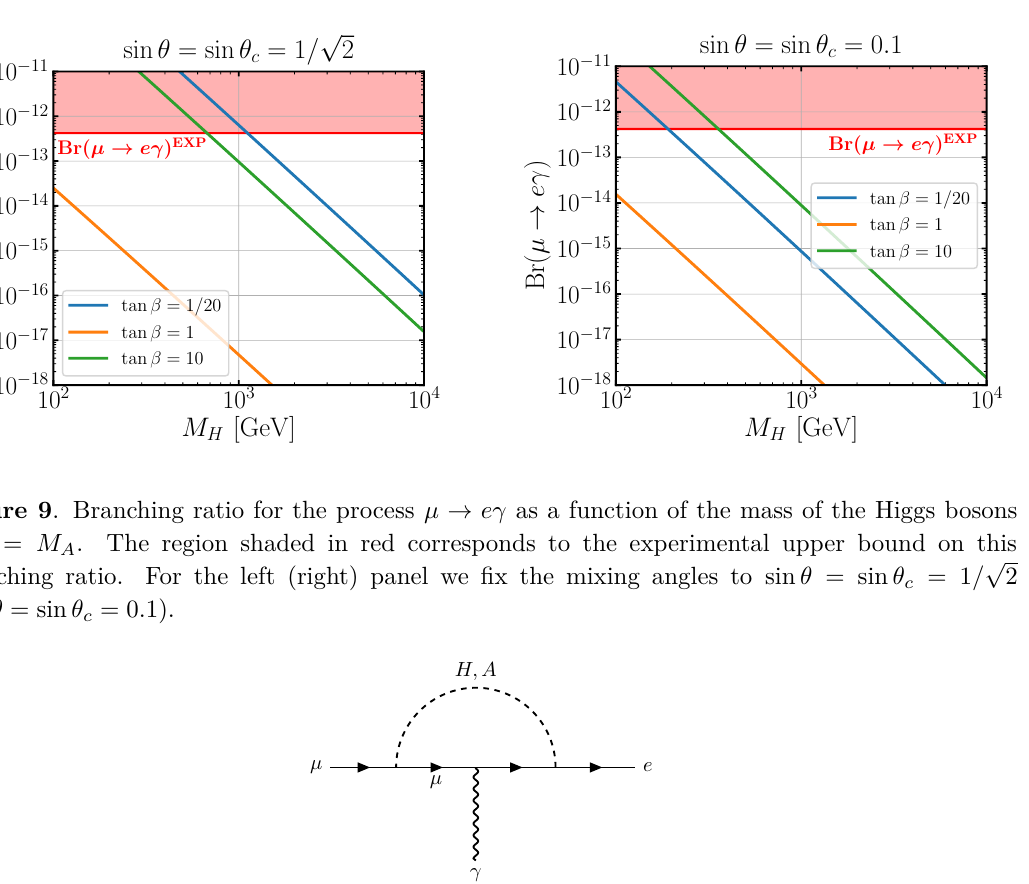
Figure 10 . Feynman diagram for the contribution from the new scalars H and A to µ → eγ . √ sin θ =sin θ =1 / 2 . The blue line corresponds to tan β =1 / 20 and the experimental c measurement of ∆ m requires M & 18 TeV; while for tan β =1 ( tan β =10 ) we K H